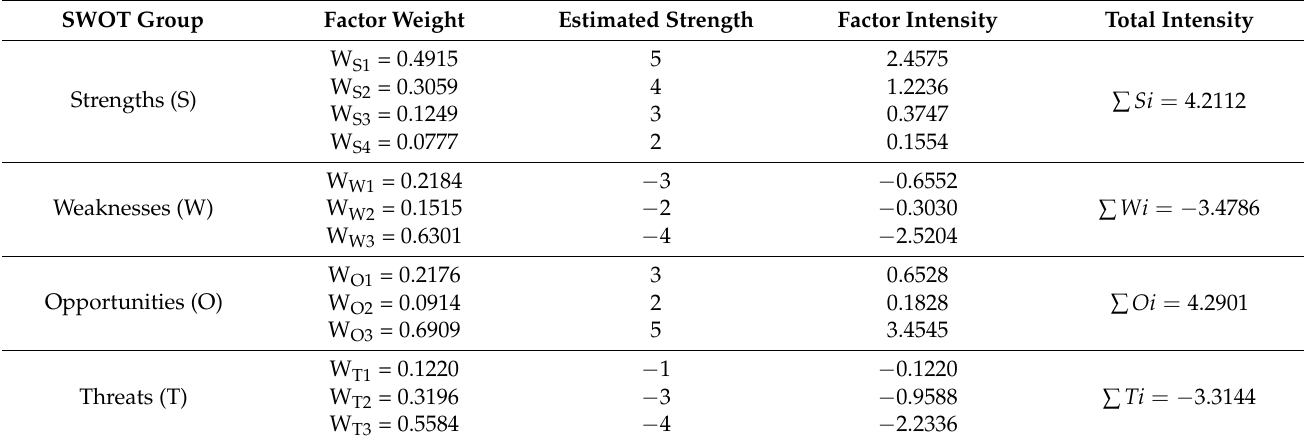
Table 5. The intensities of groups and